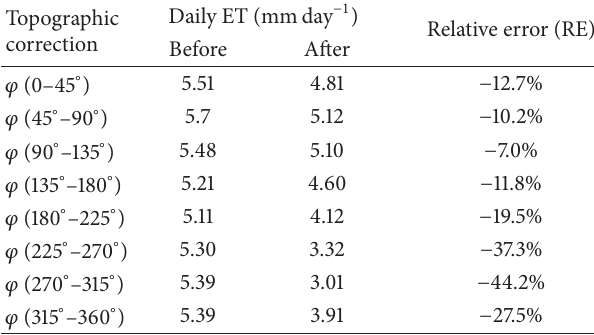
Table 1: A comparison of the daily ET before and after the topographic correction for different terrain aspect angles over the selected